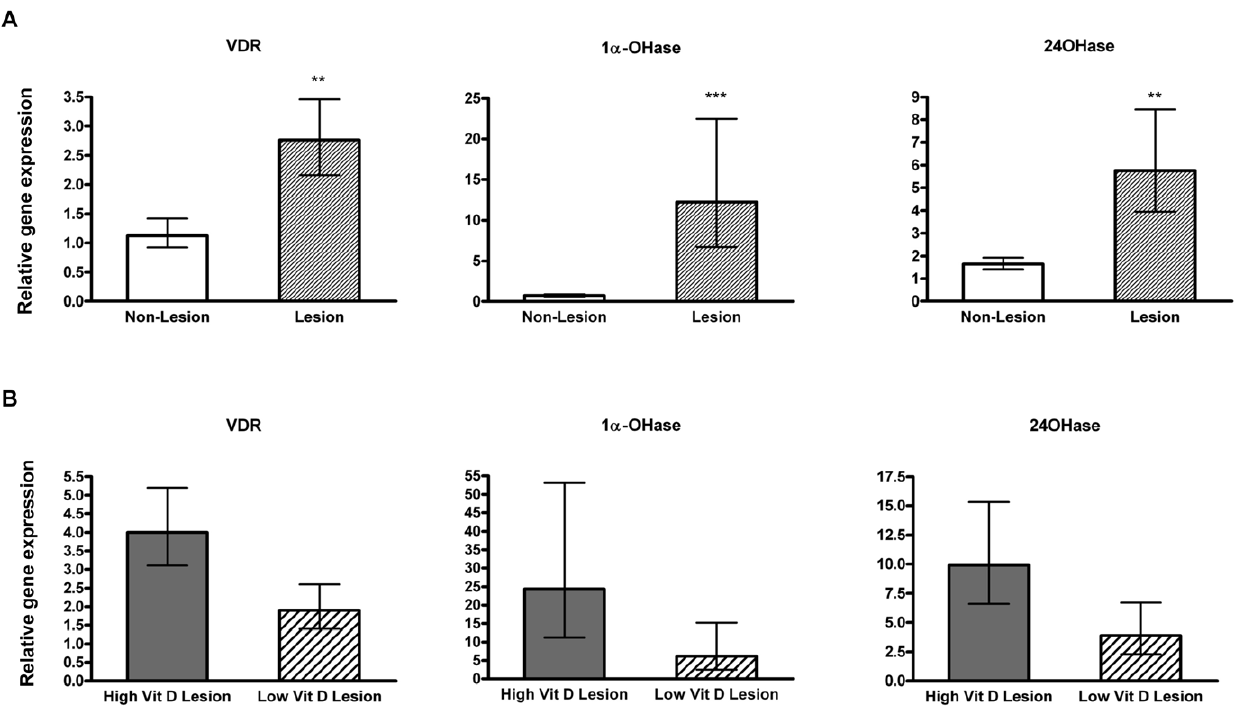
Figure 4. Nuclear VDR and hydroxylase gene expression levels in lung tissues of calves following bovine RSV experimental infection. ( A ) Vitamin D receptor (VDR), CYP27B1 (1 a -OHase), or CYP24A1 (24-OHase) mRNA levels in lesioned or non-lesioned lung samples from bovine RSV-infected calves irrespective of vitamin D treatment (n=16). ( B ) Vitamin D receptor (VDR), CYP27B1 (1 a -OHase), or CYP24A1 (24-OHase) mRNA levels in lesioned lung samples from bovine RSV-infected calves with low (n=8) or high (n=8) circulating 25(OH)D 3 levels. The amount of each target gene was determined by quantitative real-time PCR with normalization to RPS9. DD Ct values 6 SE were transformed (2 2 DD Ct ) and data are presented as the target gene expression relative to control lung samples (n=4). Statistical analysis was performed using Student’s t-test. DD Ct values were used in the analysis of relative gene expression. **P , .01,***P , .001.